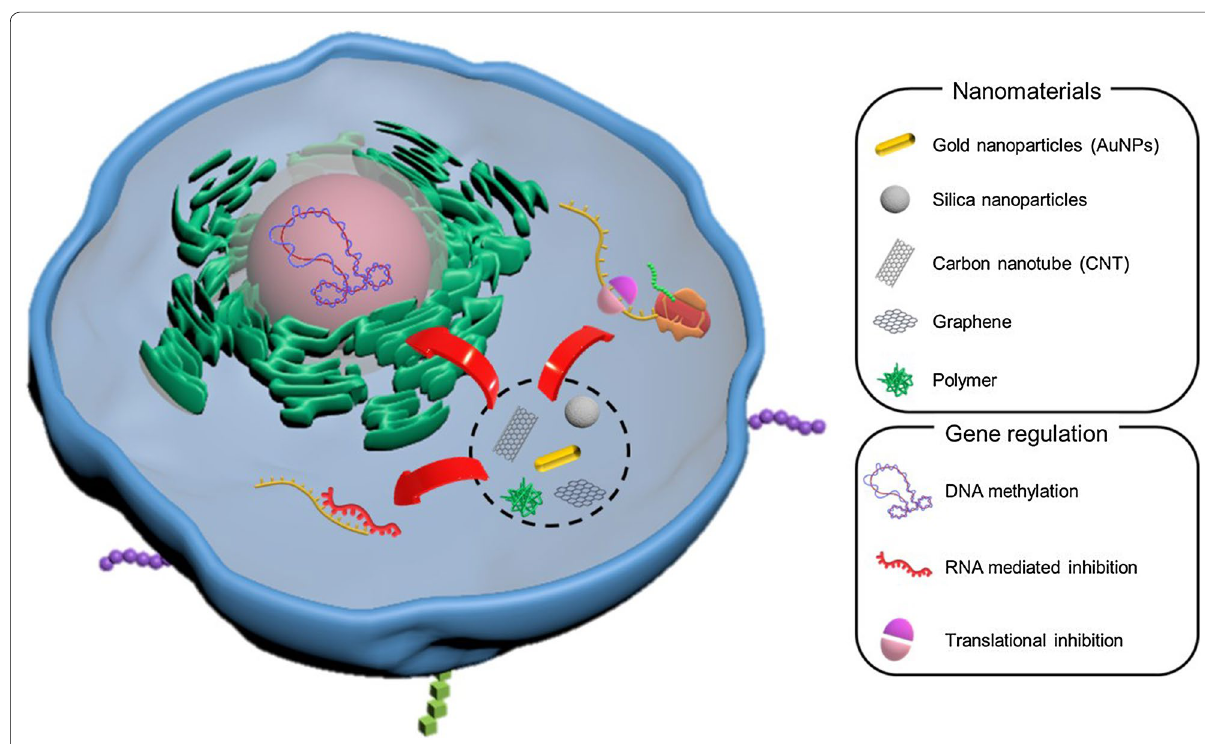
Fig. 2 Gene regulation by nanomaterials in a